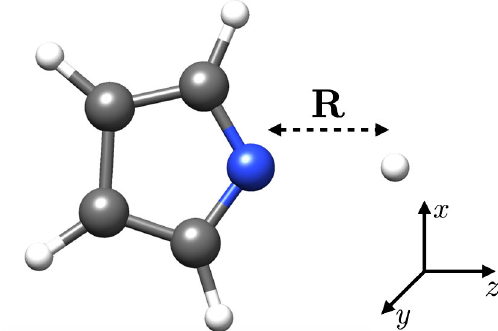
FIG. 7. Orientation of pyrrole with indication of the coordinates.